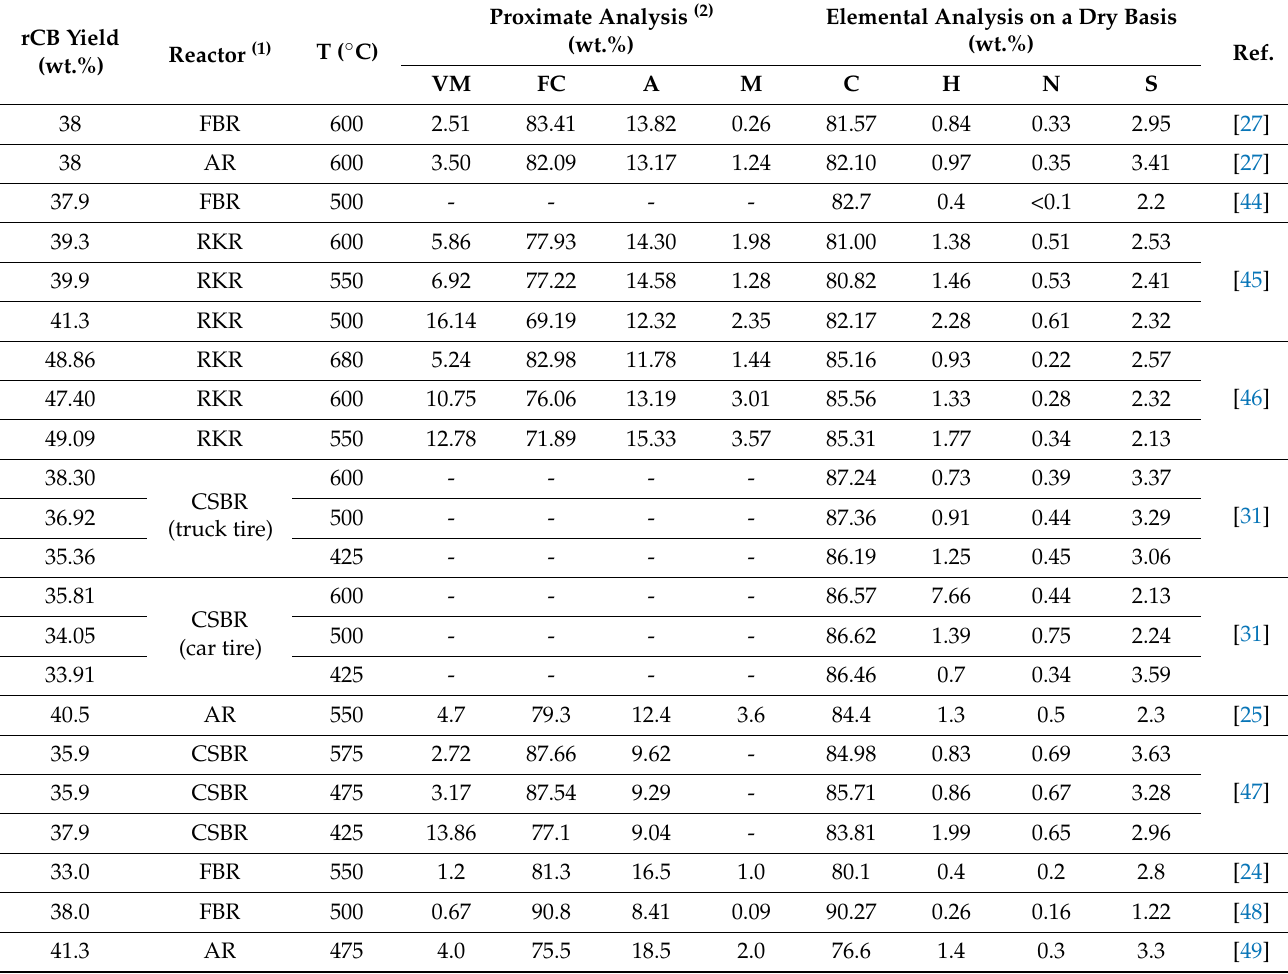
Table 1. rCB yield and composition reported in several ELT pyrolysis studies.